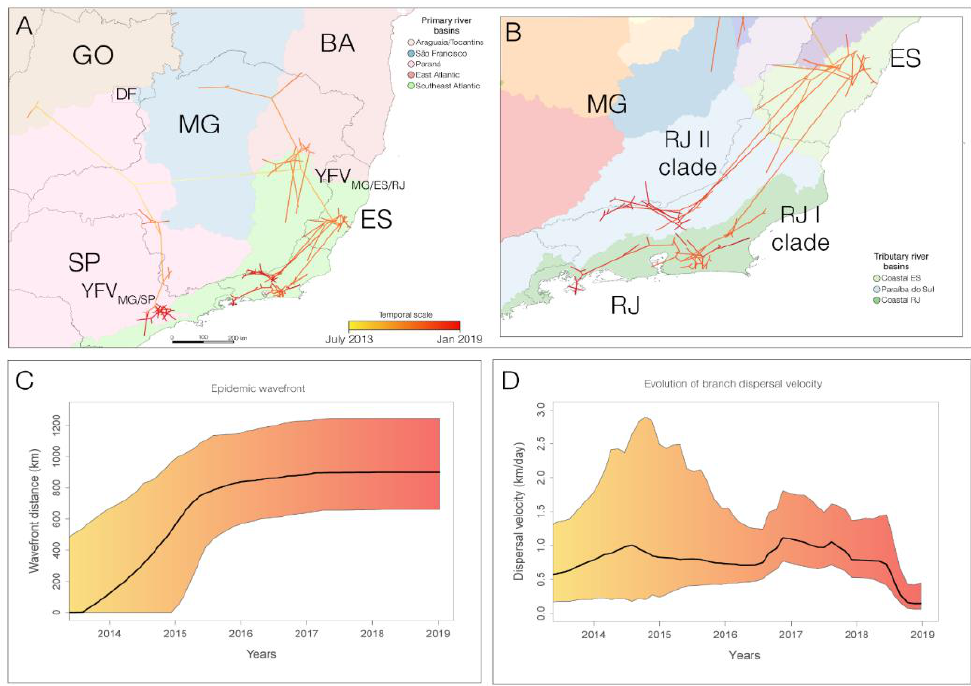
Figure – 4. Reconstructed spatiotemporal diffusion of the YFV lineage from central-west, Goiás state, and toward southeast Brazil. Phylogeny branches were arranged in space according to the internal nodes’ locations inferred by the continuous phylogeographic model. Branches were colored according to time, as indicated by the legend. The dark gray lines represent the Brazilian state’s boundaries while the colored areas show the different primary river basins ( A ) and additional details on tributary basins ( B ), where are depicting the two routes of YFV of dissemination in RJ state arose on each side of Serra do Mar, expanding to clade YFV RJ-I and clade YFV RJ-II. Progression of maximal wavefront distance ( C ) estimated for the YFV 2015 – 2019 outbreak based on continuous phylogeographic analysis. The wavefront represents the spatial distance between the farthest extent of the wavefront and the position of the most ancestral node. Progression of mean dispersal velocity over time (km per day) ( D ) estimated for the YFV 2015 – 2019 outbreak. For ( C , D ), the colored area corresponds to the 95% credible regions of the estimation. The Brazilian states boundaries and primary river basins information were retrieved from Instituto Brasileiro de Geografia e Estatística [IBGE] [43] . Brazilian states: DF, Distrito Federal; ES, Espírito Santo; GO, Goiás; MG, Minas Gerais; RJ, Rio de Janeiro; SP, São Paulo.